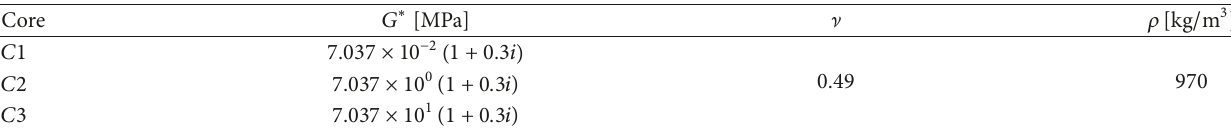
Table 10: Core material properties.